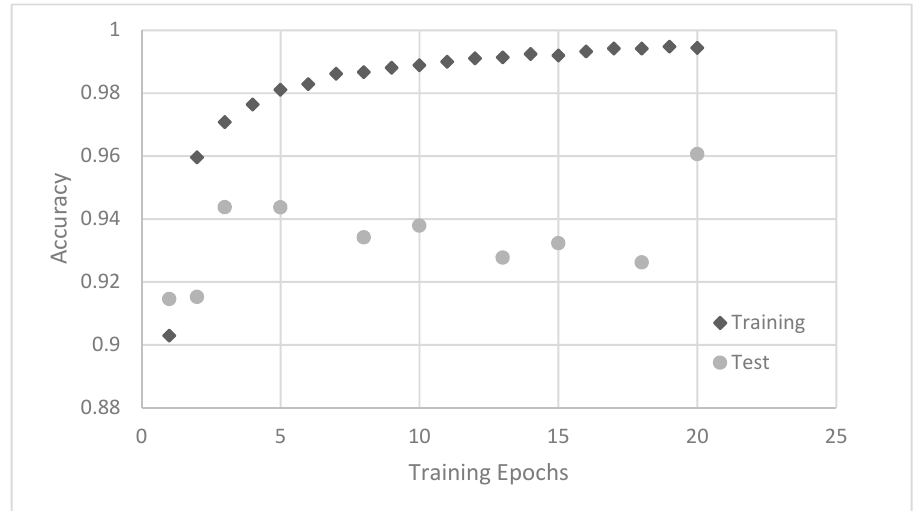
Figure 6. Training accuracy and test accuracy of a convolutional neural network with 16 filters.